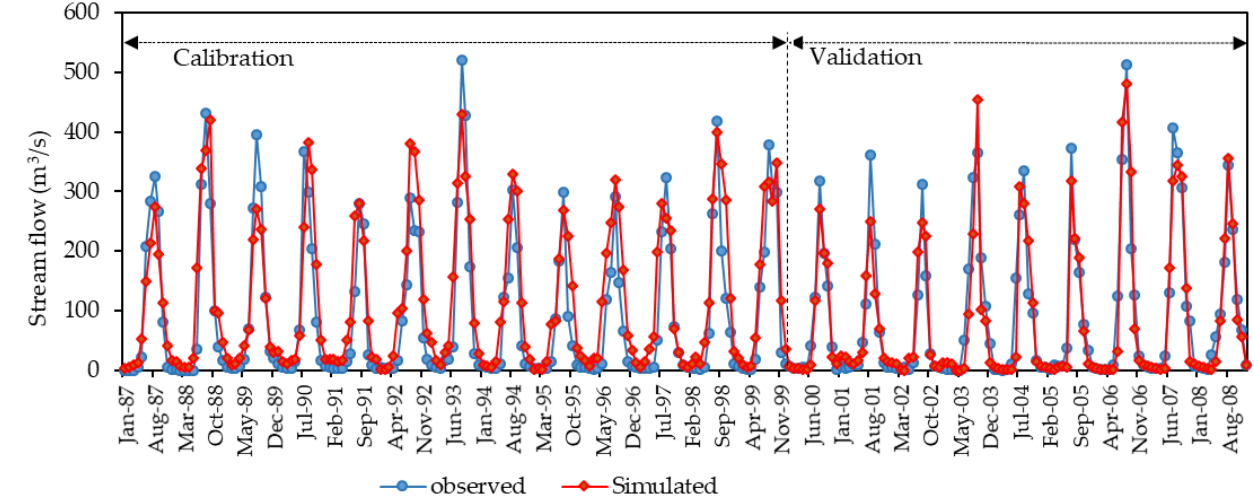
Figure 5. Observed and simulated average monthly stream flow of the Nashe watershed. The average annual changes of stream flow show 1.15%, 1.36%, and 1.62% in 2019, 2035, and 2050, respectively, with respect to the historical (2005) simulated stream flow.